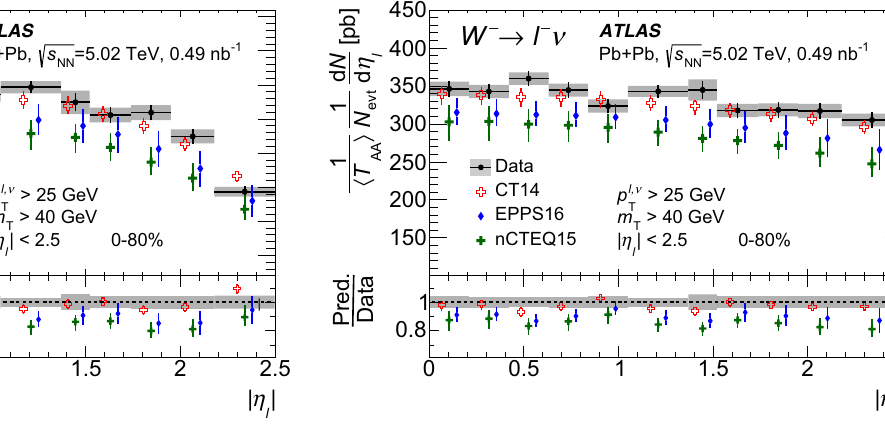
and nCTEQ15 nPDF sets. For the theory predictions, the error bars rep- resent total uncertainties due to PDF uncertainties, scale variations and α S variations. The lower panels show the ratios of predicted yields to the measured ones, and the shaded band shows the sum in quadrature of statistical and systematic uncertainties of the data. The points for theory predictions are shifted horizontally for better visibility